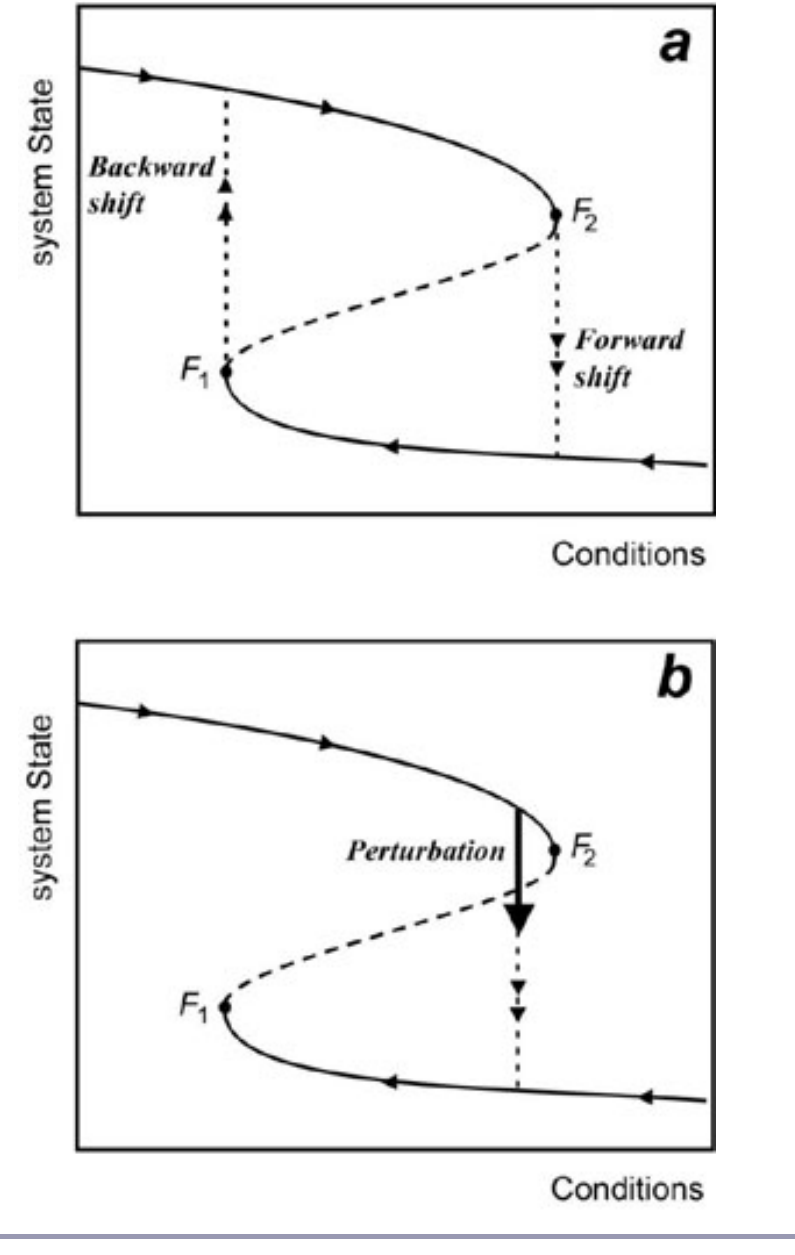
Fig. 2. Two ways to shift between alternative stable states. (a) If the system is on the upper branch, but close to the bifurcation point F2, a slight incremental change in conditions may bring it beyond the bifurcation and induce a catastrophic shift to the lower alternative stable state (“forward shift”). If one tries to restore the state on the upper branch by means of reversing the conditions, the system shows hysteresis. A backward shift occurs only if conditions are reversed far enough to reach the other bifurcation point F1. (b) A perturbation (heavy arrow) may also induce a shift to the alternative stable state, provided that it is sufficiently large to bring the system over the border of the attraction